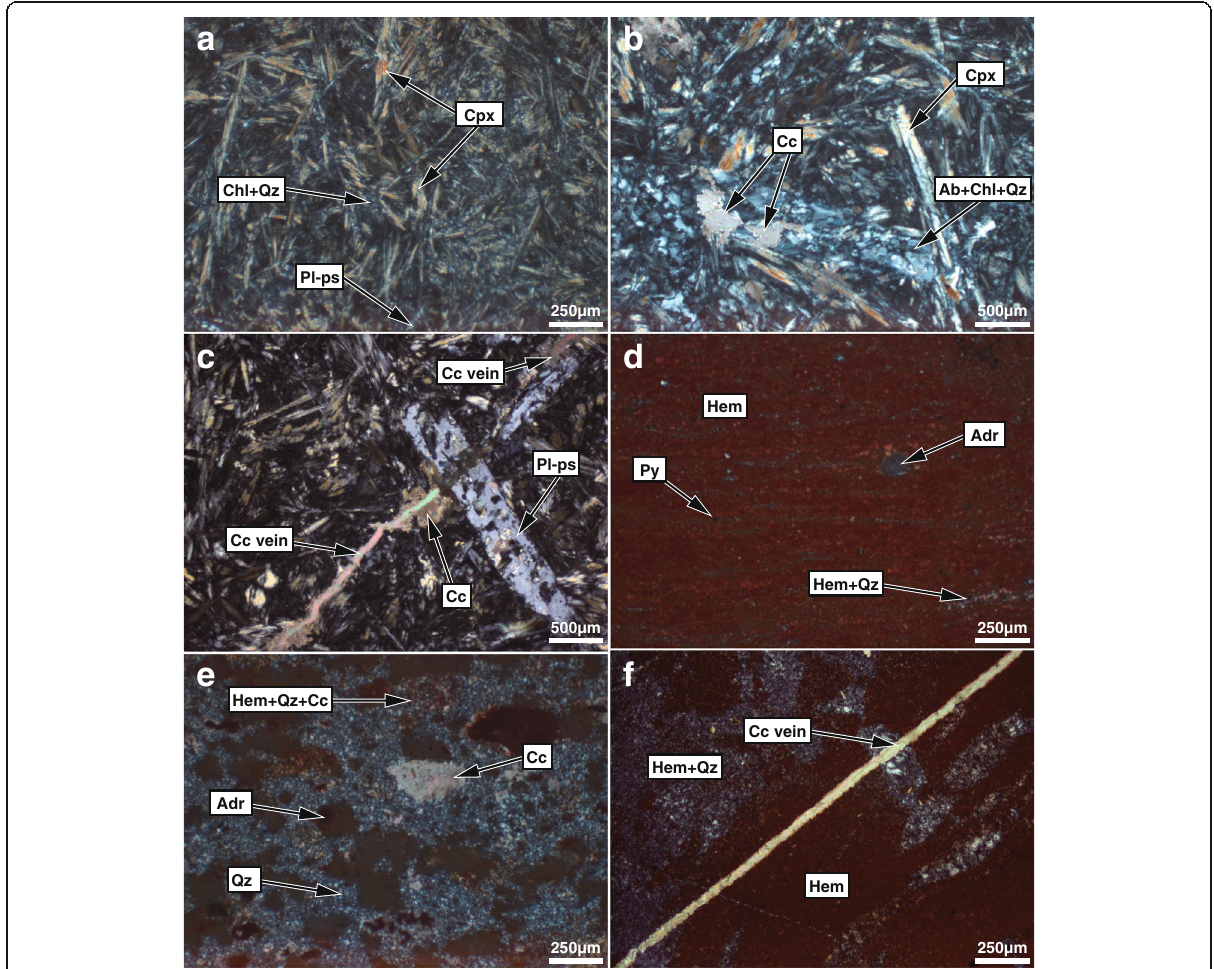
Fig. 3 Photomicrographs of basaltic andesites and hydrothermal jaspilites in the Ongeluk Formation. a A typical basaltic andesite in which the igneous minerals and glass have been replaced by secondary minerals but the igneous texture is well preserved. b Disseminated calcite-bearing basaltic andesite in which igneous plagioclase has been replaced by secondary albite, chlorite, quartz, and calcite. c A calcite vein cutting all alteration minerals and igneous texture. d A hematite-rich layer of interpillow hydrothermal jaspilite. e A microquartz-rich layer of the interpillow hydrothermal jaspilite that includes calcite and andradite. f A calcite vein cutting